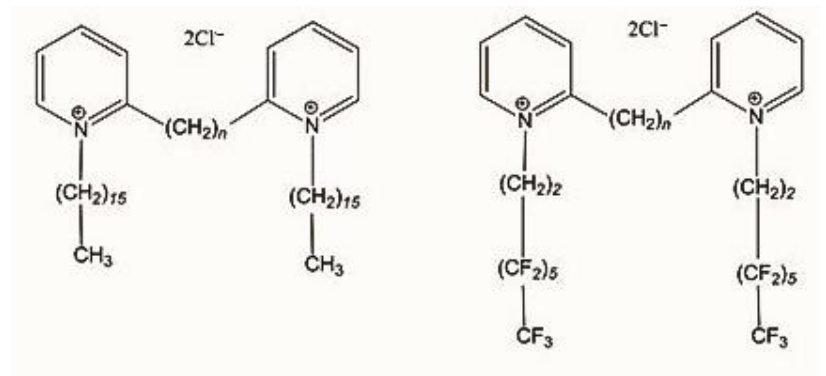
Figure 1. Compounds under study, n is the number of carbon atoms in the spacer.